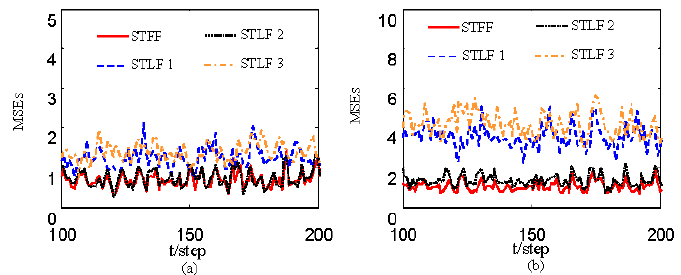
Figure 5. Distributed ST fusion filter: ( a ) The first state component; ( b ) The second state component.